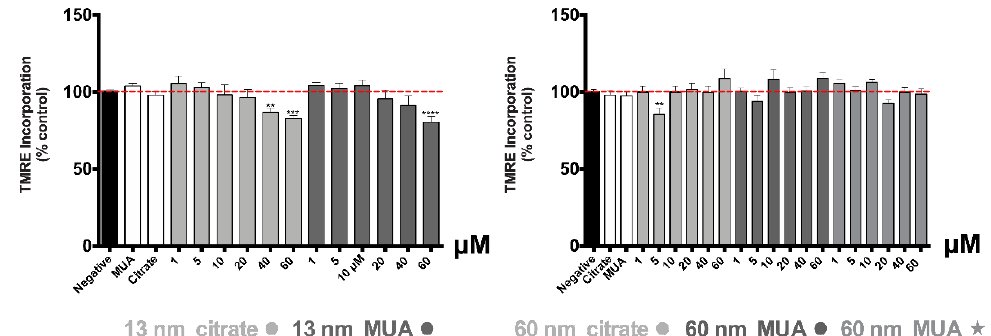
Figure 3. Mitochondrial membrane potential (Δ ψ m) indirectly assessed by the TMRE incorporation in mitochondria of HK-2 cells, after 24 h incubations at 37 °C with AuNPs. Results from at least four independent experiments, run in triplicates, are expressed as percentage control ± standard error of the mean (SEM). Statistical comparisons were made using one-way ANOVA / Dunnett’s post hoc test ** p ≤ 0.01; *** p ≤ 0.001; **** p ≤ 0.0001 versus control.